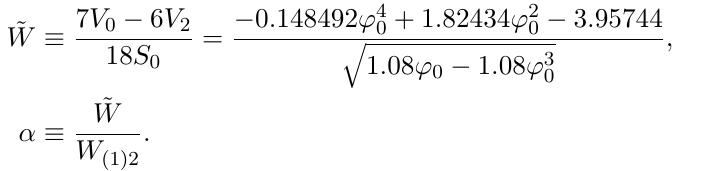
= ˜ W , the two functions (1)2